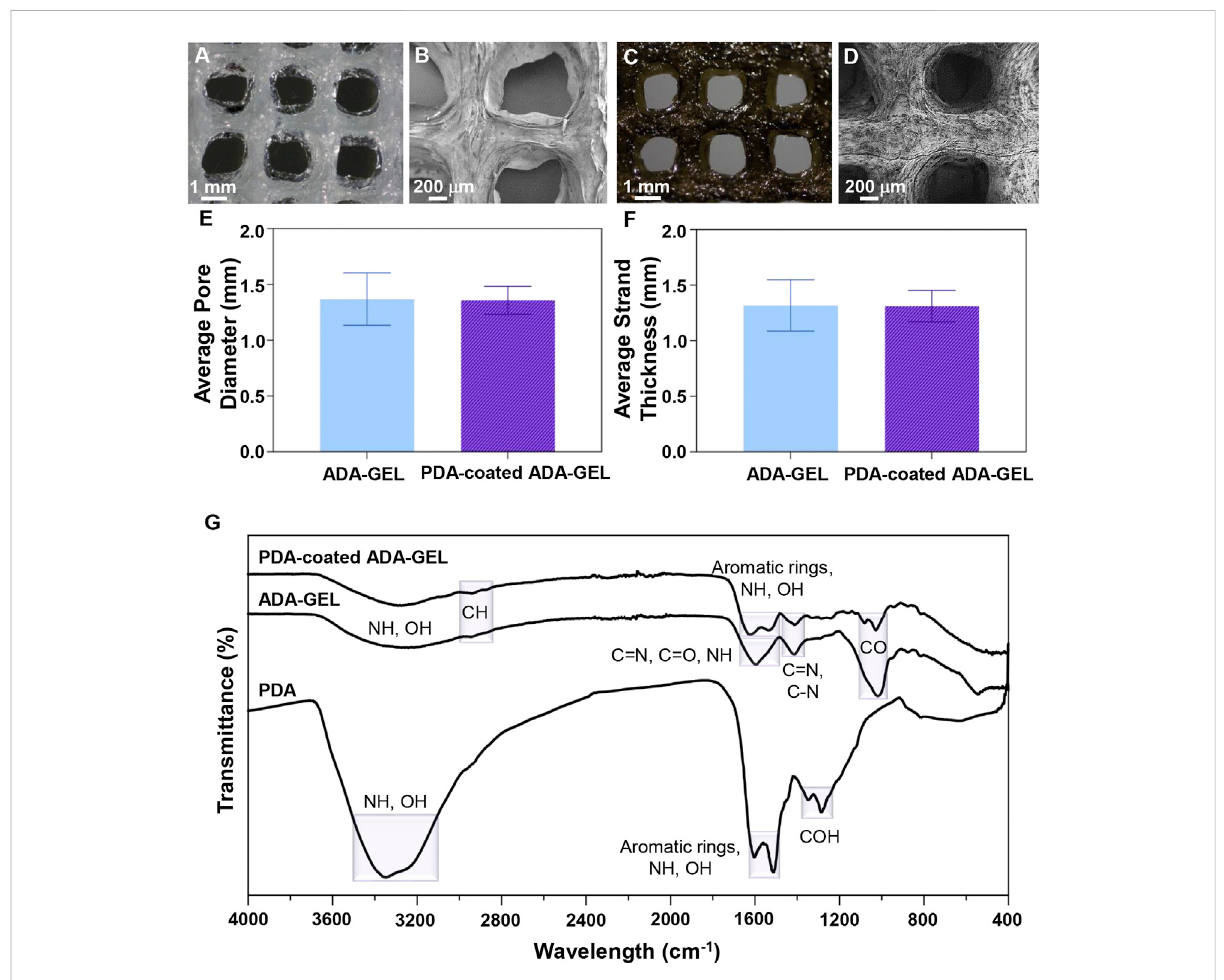
FIGURE 2 Microstructural and chemical evaluation of scaffolds. (A,C) Light microscope images and (B,D) FE-SEM images of (A,B) ADA-GEL and (C,D) PDA-coated ADA-GEL scaffolds. (E) Average pore diameter and (F) average strand thickness of ADA-GEL and PDA-coated ADA-GEL scaffolds. (G) Chemical characterization of polymeric scaffolds. FTIR spectrum of PDA, ADA-GEL, and PDA-coated ADA-GEL